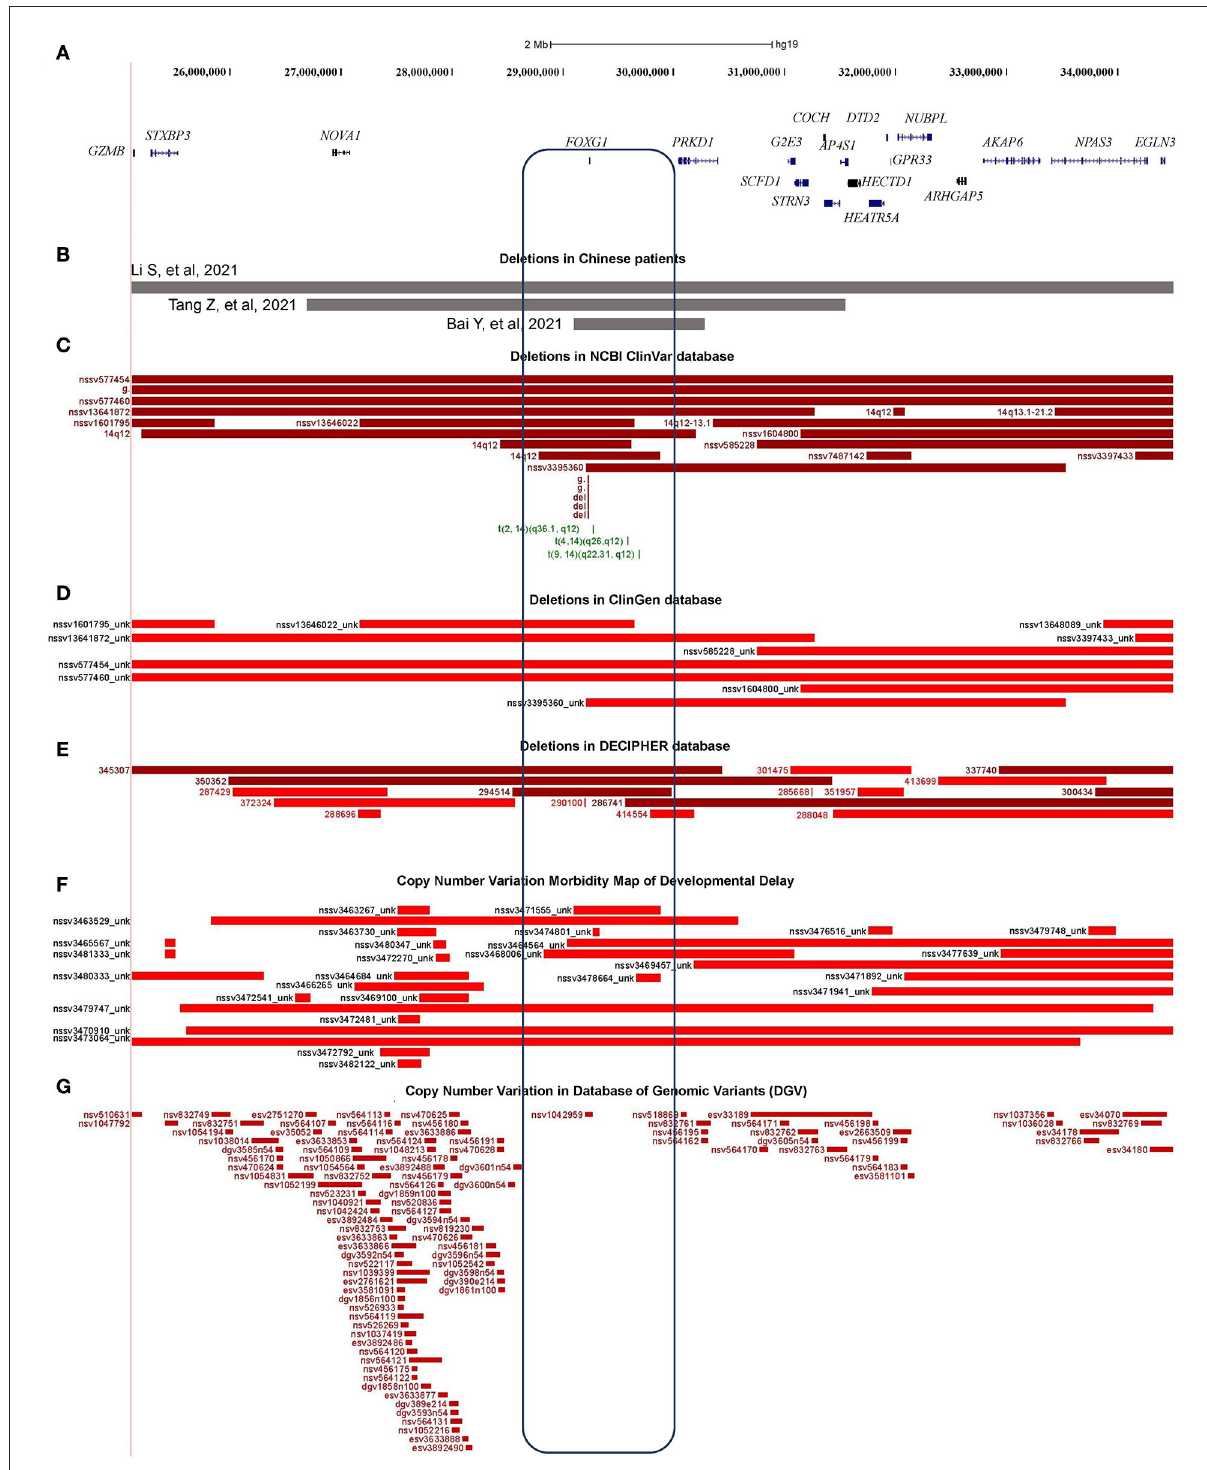
FIGURE4 Characterization of the microdeletions containing FOXG1. (A) Genomic regions and protein coding genes of microdeletion in patients 9, 10, and 11; (B) Covered regions of the two Chinese microdeletions; (C) Microdeletions in ClinGen database; (D) Microdeletions in NCBI’s ClinVar database; (E) Microdeletions in DECIPHER database; (F) Microdeletions in Developmental Delay; (G) Microdeletions in Database of Genomic Variants